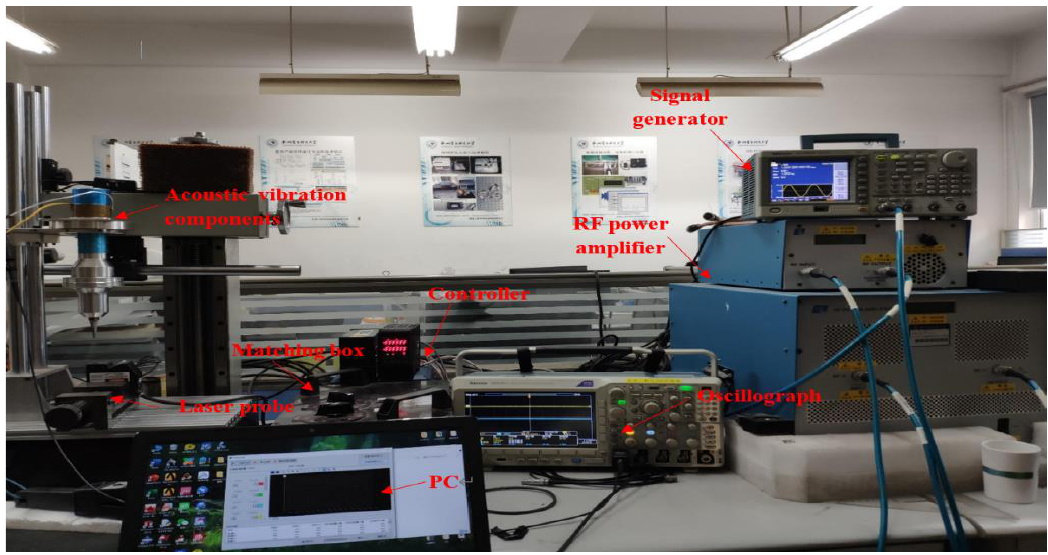
Figure 5. Acoustic Vibration Component Dynamic Performance Experiment Set.